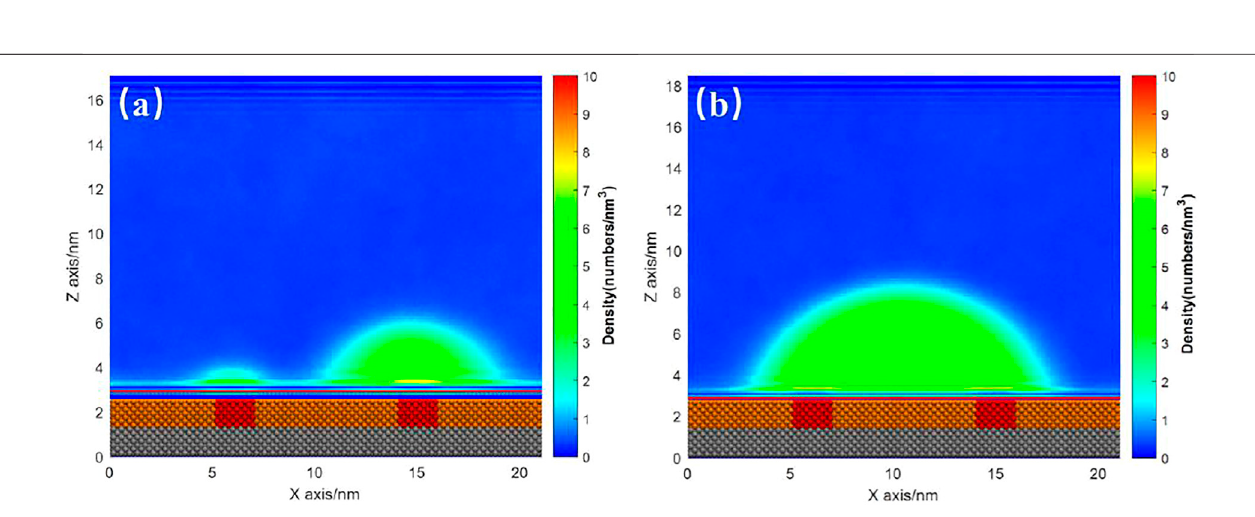
Frontiers in Materials |